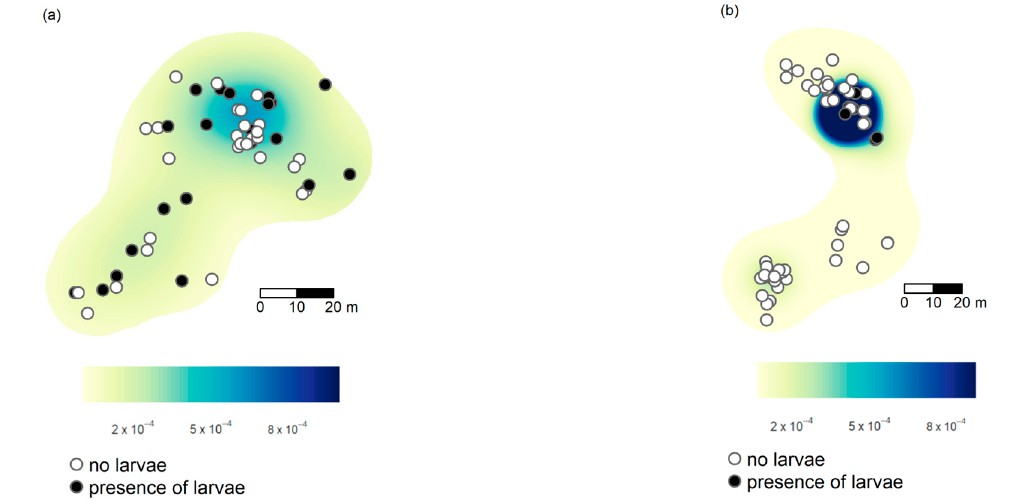
Figure 3. Kernel-smoothed density of Myrmica nests infested by Ma. teleius larvae, with superimposed locations of Ma. teleius larvae, in Kraków ( a ), or Kosy ń ( b ), at the end of larval development.